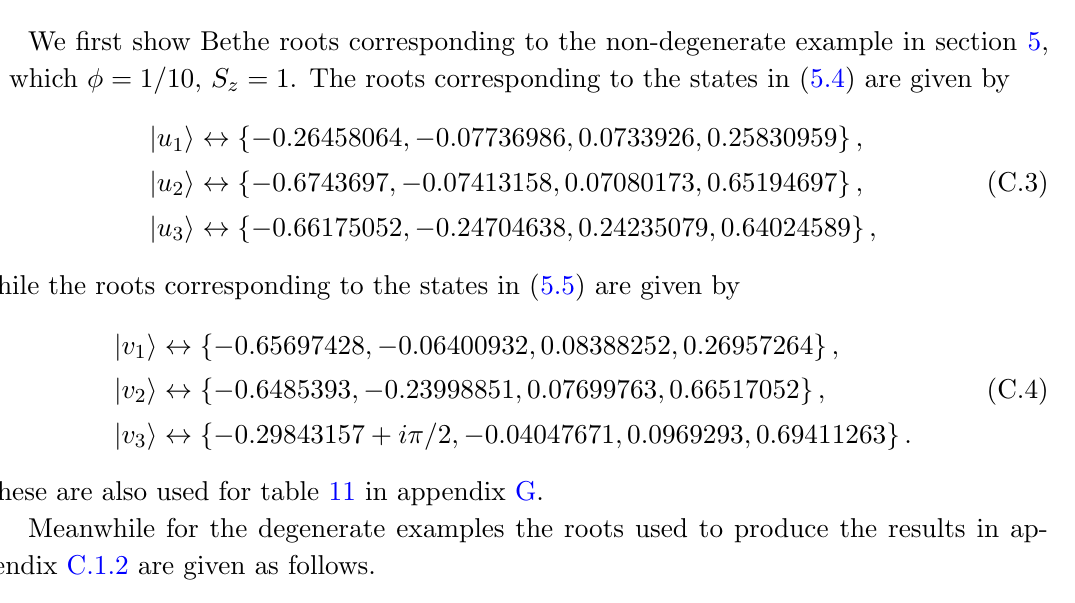
Table 6 . Matrix elements of L (cid:6) 1 and (cid:22) L (cid:6) 1 in the sector of S z = 1, at x = (cid:25) , with the same conventions as in table 3. In this table e = (cid:0) 1 is considered again. Polynomial extrapolations p n (1 =N ) of degrees n = 25 ; 30 ; 35 to all the data points are made in order to approximate the value at N ! 1